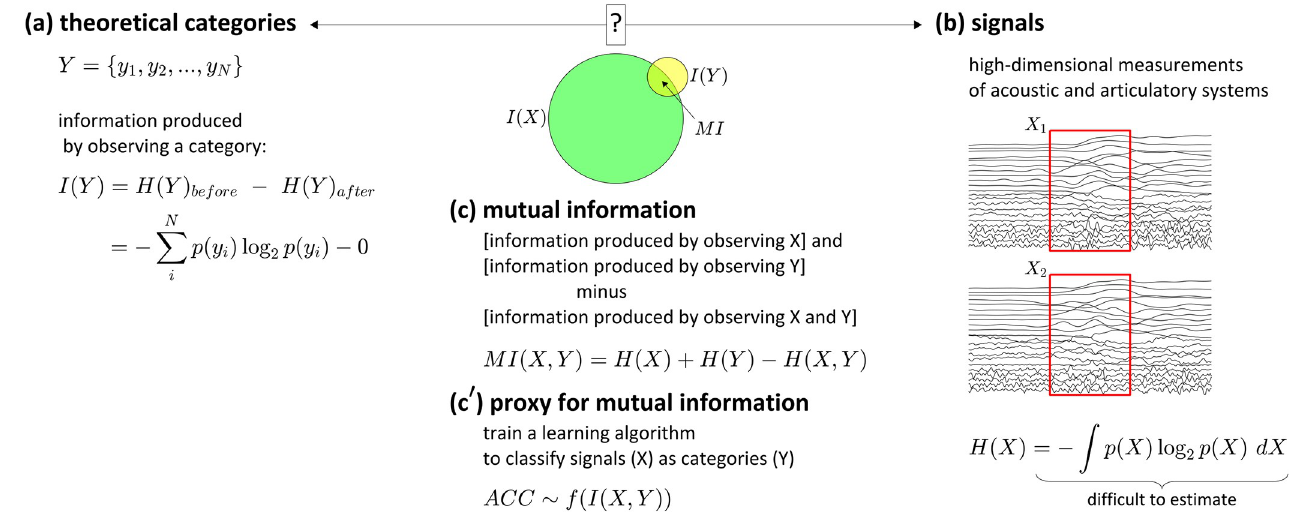
Fig 1. Information-theoretic interpretation of the task of localizing categories and signals. (a) Information produced by observing a category. (b) Information produced by observing signals. (c) Mutual information between categories and signals is calculated as the information produced by observing the signals and categories independently minus the information produced by observing them jointly. (c’) Because it is difficult to estimate the information of the signals, the classification accuracy of a learning algorithm with signals as input is treated as a proxy for mutual information.